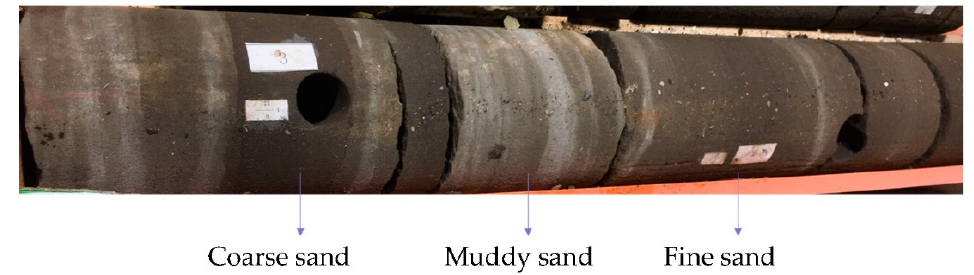
Figure 1. Lithology heterogeneity of the formation.